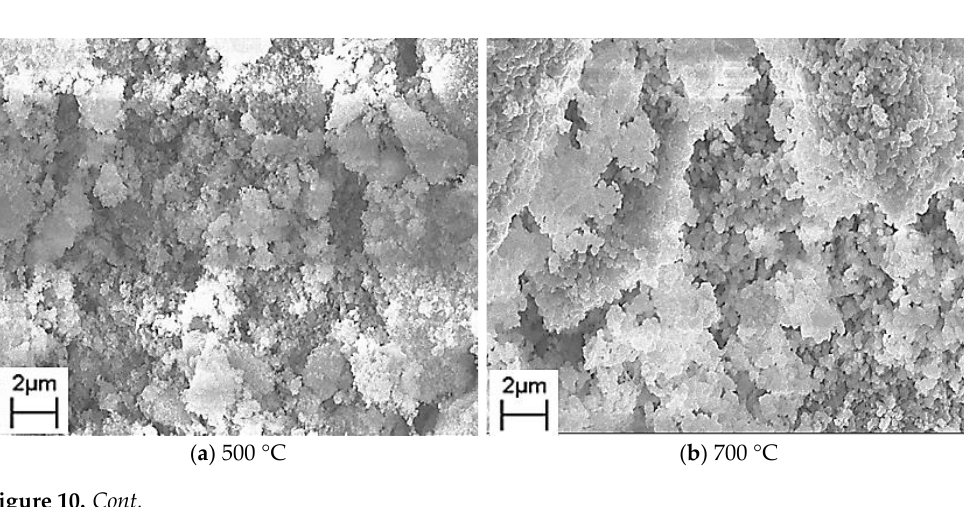
Figure 9. The compressive and bending strengths of the CaNa ceramic samples after annealing at temperature range of 500 – 900 °C.